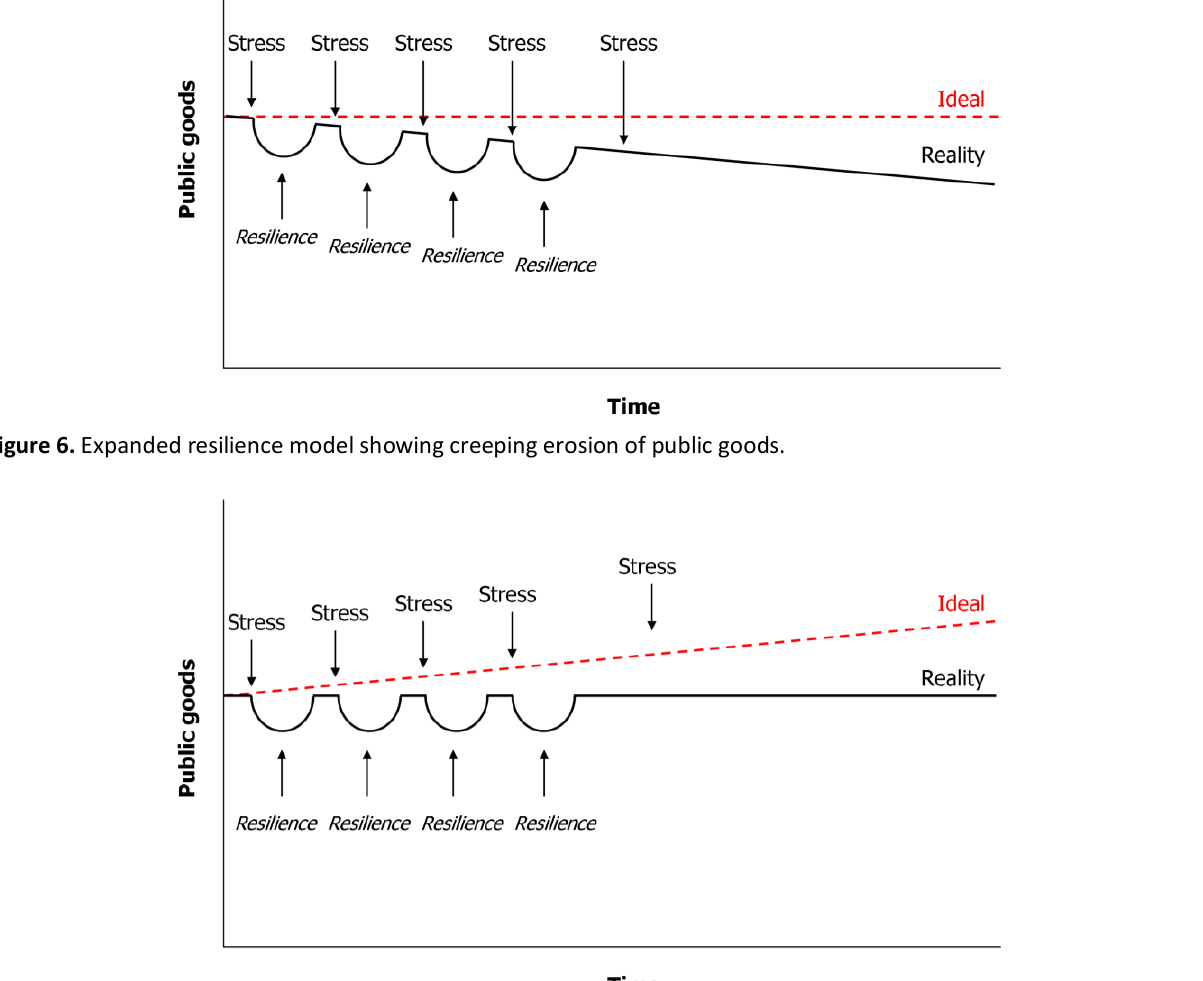
Figure 7. Expanded resilience model showing enhancement of public